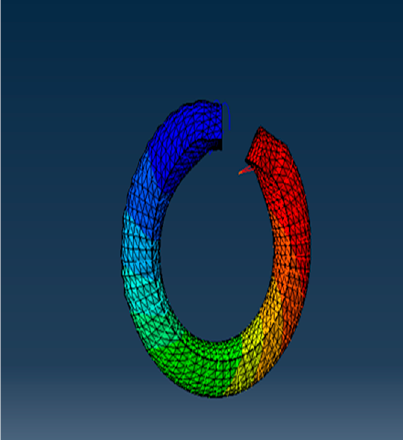
Figure 8. Open loop simulation of the SPA.